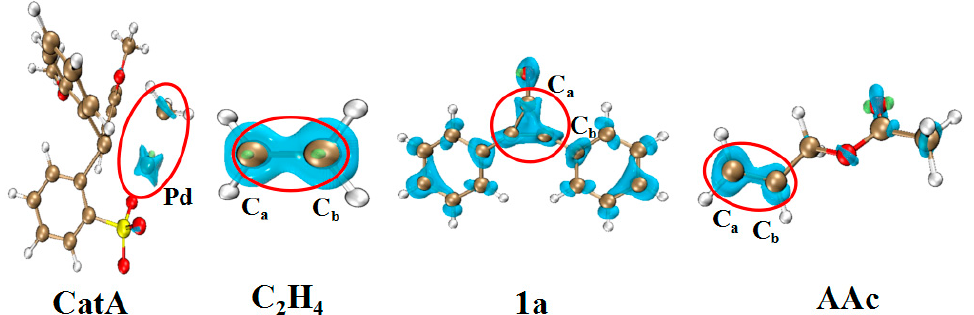
− ) in C 2 H 4 , 1a b ( f